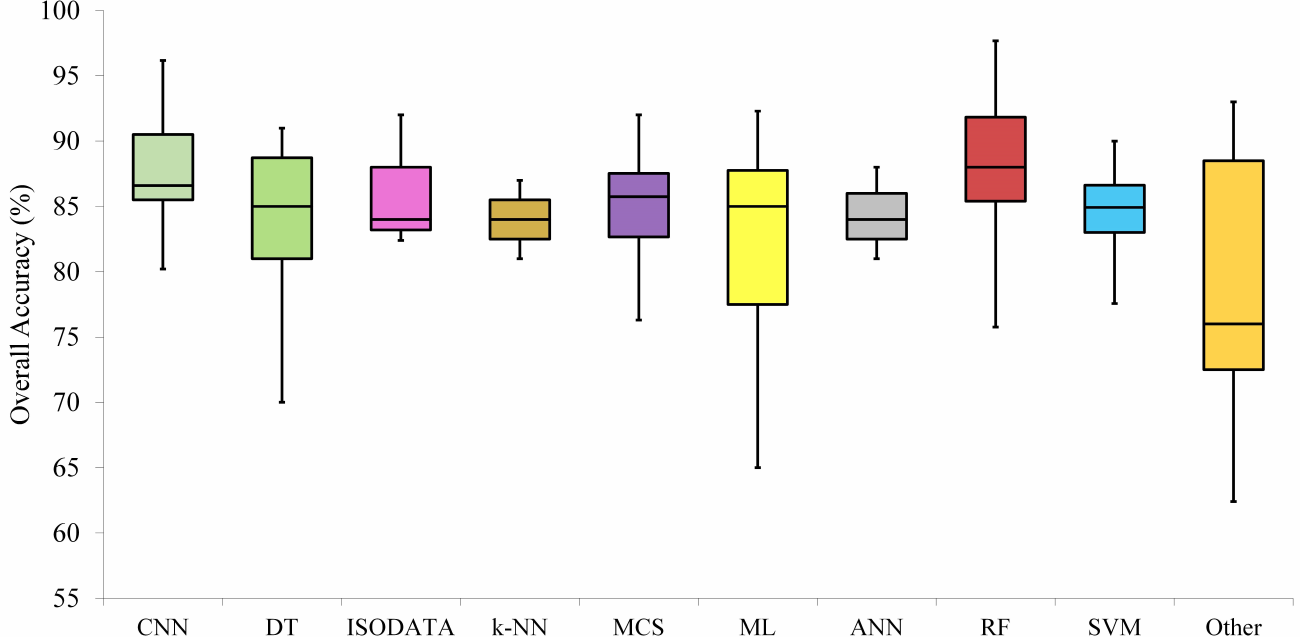
Figure 12. Boxplot distributions of the overall accuracies obtained by different classifiers used for wetland classification in